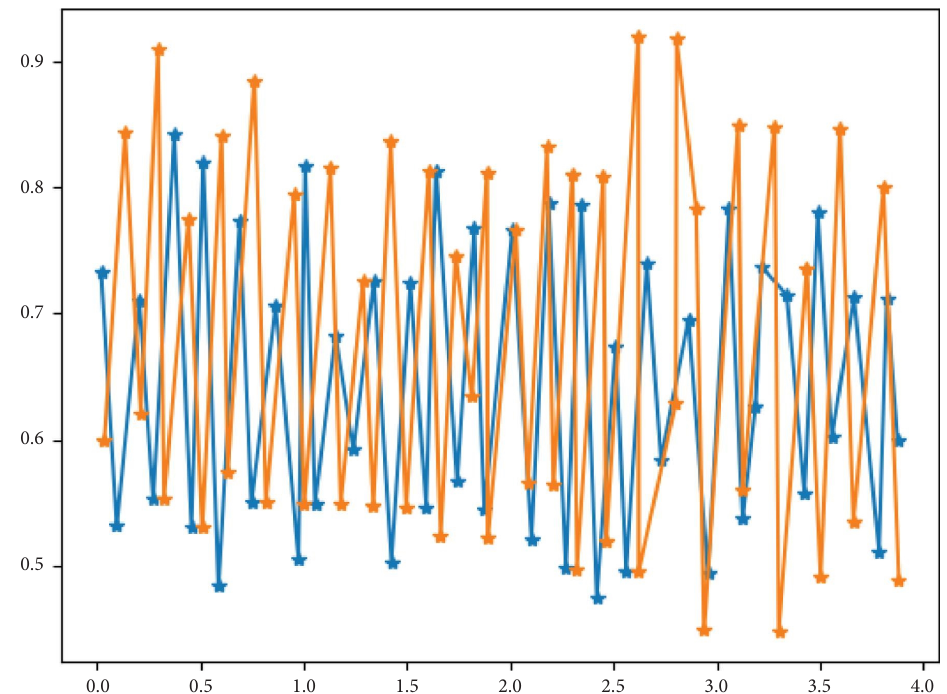
Figure 15: Efect diagram of phase shifting current sharing of inductance current under inconsistent